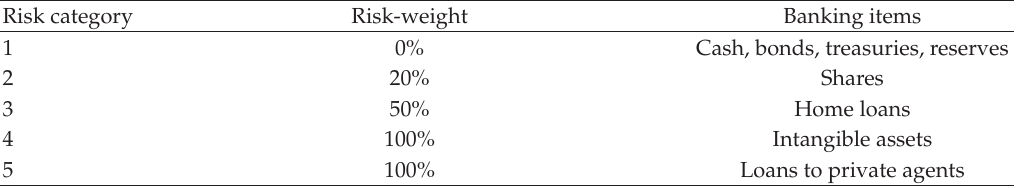
Table 1: Risk categories, risk-weights and representative